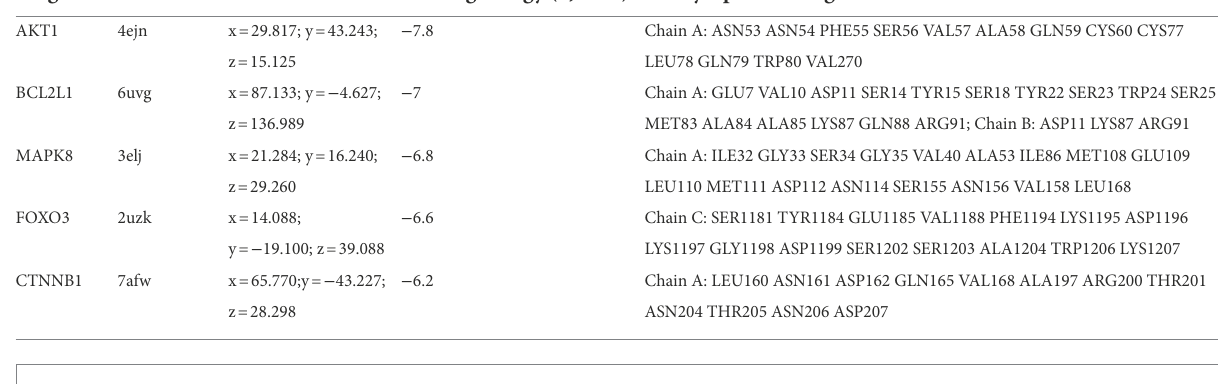
TABLE 2 Molecular docking parameters of cordycepin core targets.